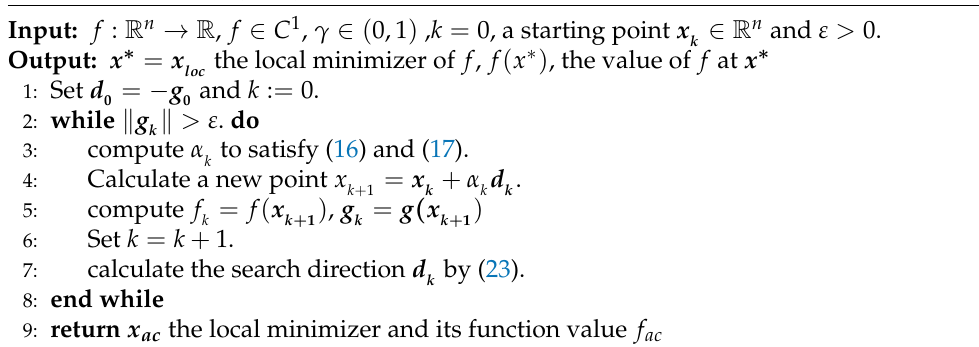
Algorithm 1 A conjugate gradient method